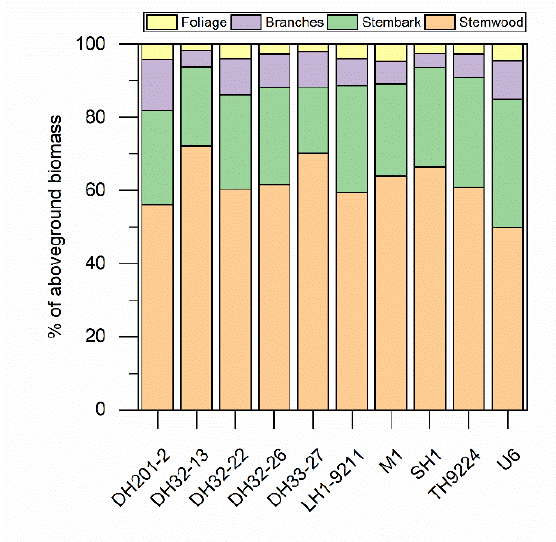
Figure 3. Biomass content of various tree components for ten Eucalyptus Clones. Significant differ- ences within each variable among clones were tested using Tukey’s HSD test (0.05 level); different small letters denote differences in means among clones.